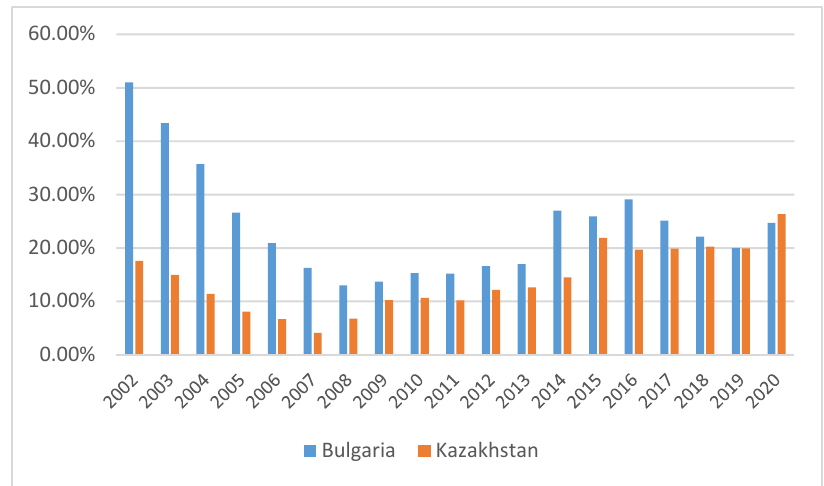
Figure 5. Government debt Bulgaria vs. Kazakhstan (percentage of GDP). Source: Created by the authors based on data https://countryeconomy.com.